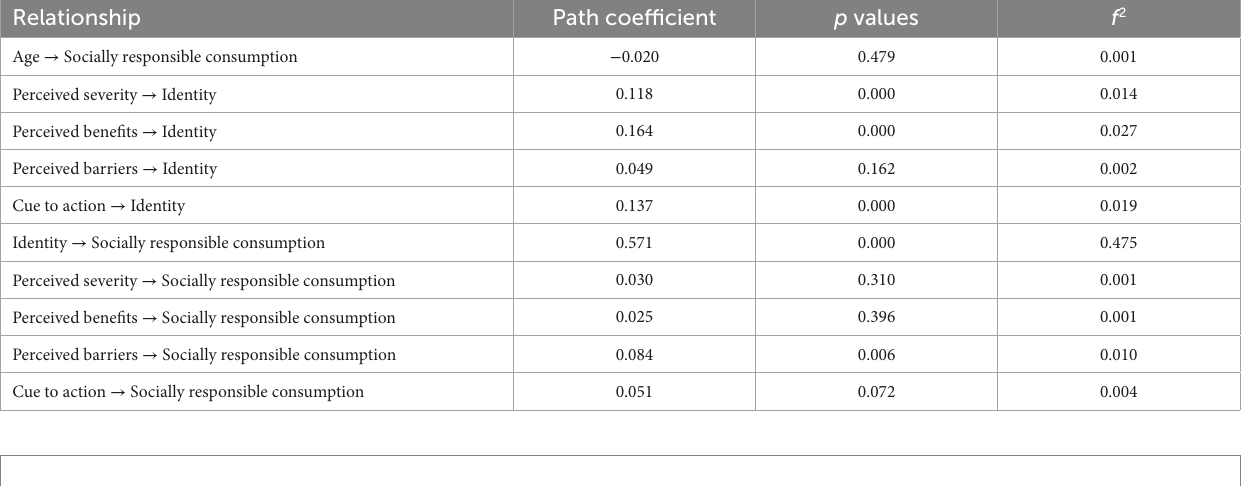
TABLE 12 Results of the alternative conceptual model.